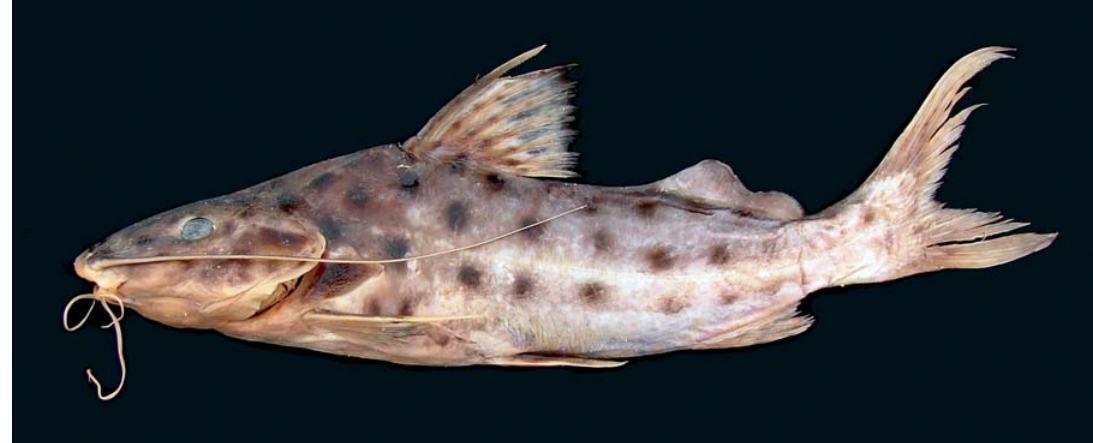
Fig. 5. Lateral view of Pimelodus britskii , MZUSP 50037, paratype 262.0 mm SL, rio Iguaçu, downstream from Salto Osório dam at Quedas do Iguaçu.